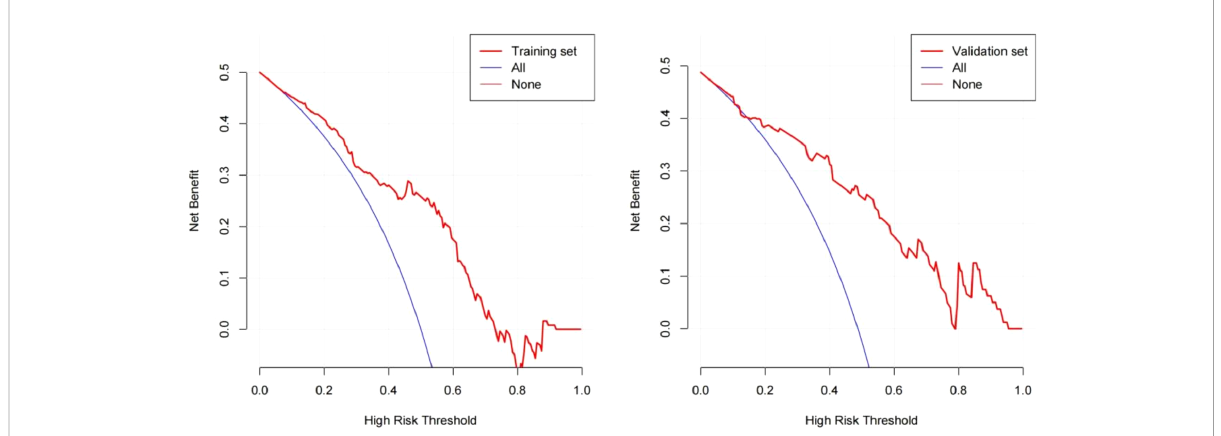
FIGURE 3 Decision curve analysis for the nomogram based on clinical characteristics. The red polyline represents the nomogram. The horizontal line with an ordinate of 0 represents all negative samples. For these participants, the treat-none scheme was applied. The blue fi ne line represents all positive samples, and for these participants, the treat-all scheme was